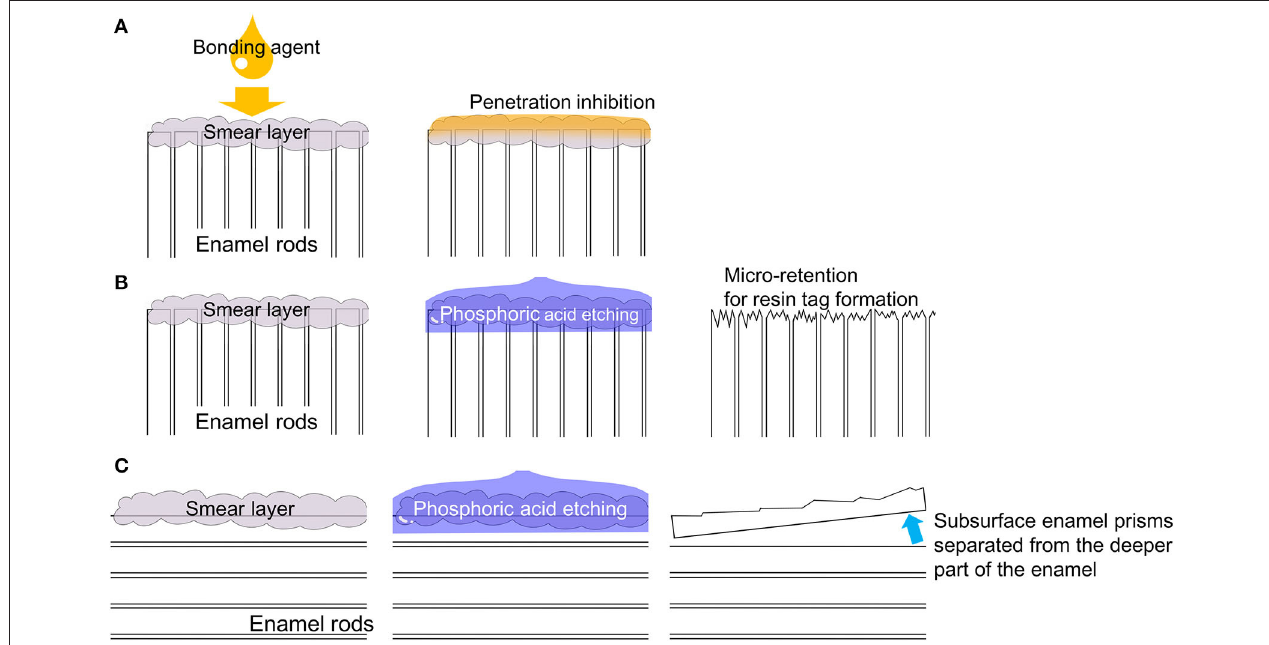
FIGURE 2 | Effects of regional enamel and prism orientation. (A) For monomer penetration, the smear layer should be removed by etching. (B) A horizontally sectioned enamel surface is roughened by PA etching. (C) Unsupported apatite crystals were observed on the surface of axially sectioned enamel after PA